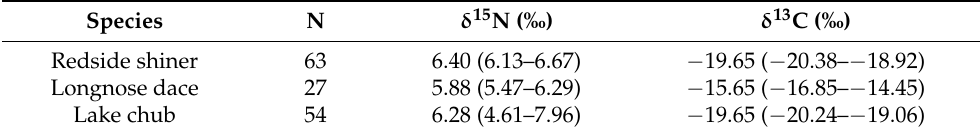
Table 3. Mean stable isotope signatures and 95% confidence intervals (CI) for redside shiner, longnose dace, and lake chub collected in the littoral zone of Yellowstone Lake during the ice-free season of 2020. Species N Redside shiner